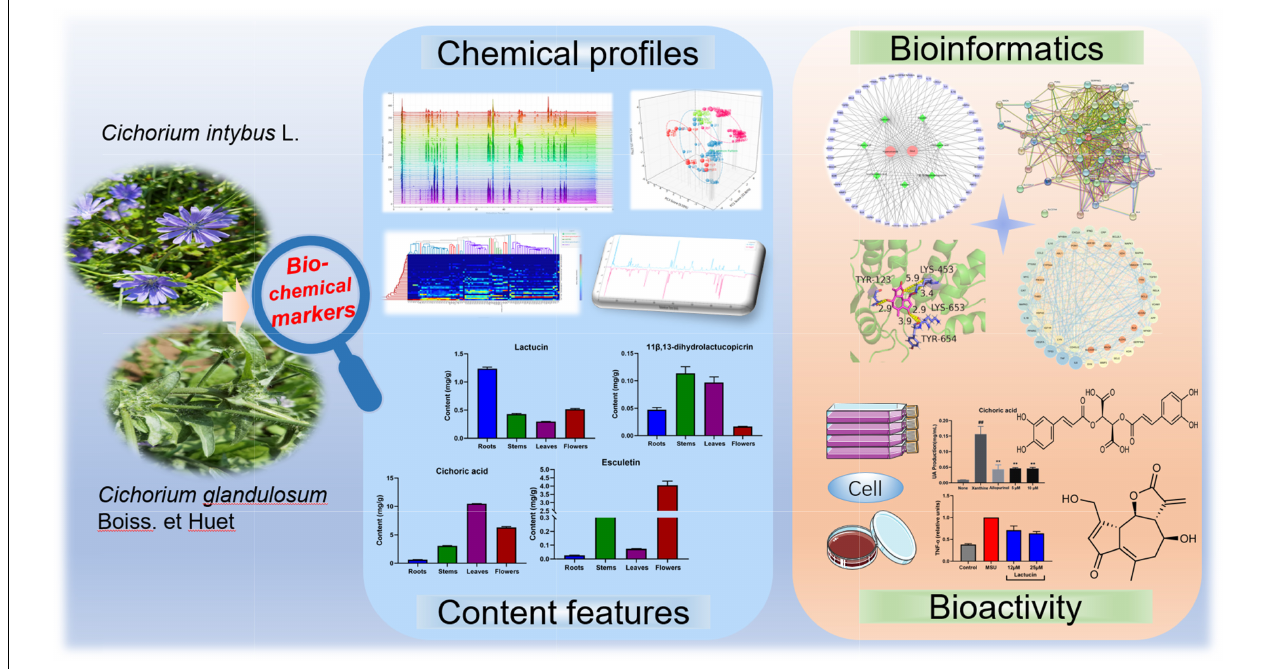
FIGURE 1 | Workflow for bioactive-chemical Q markers revealed in